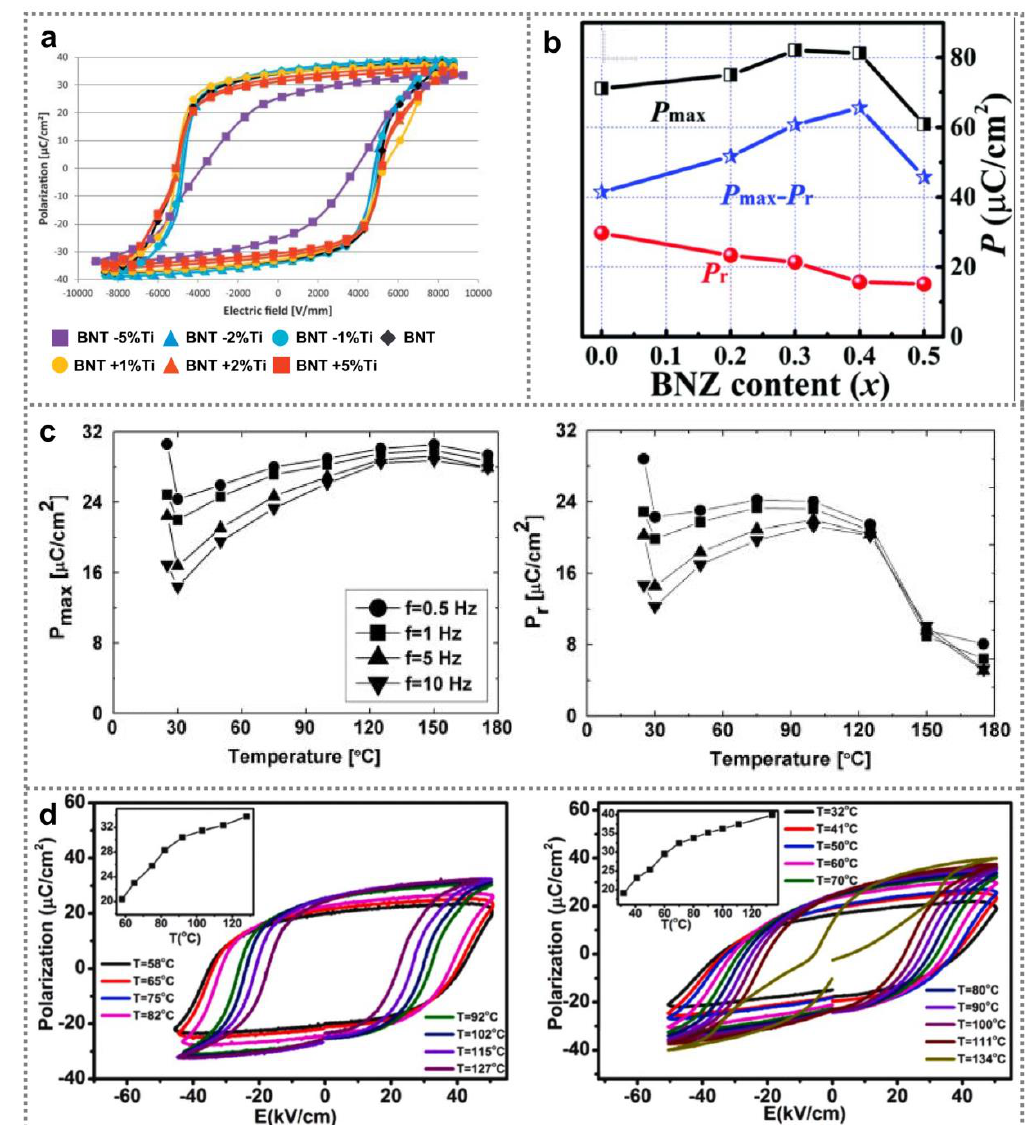
Figure 2. Ferroelectricity of BNT ferroelectric nanomaterials. ( a ) P - E hysteresis loop from BNT ceramic samples containing various amount of Ti (Reproduced with permission from [50], Elsevier, 2014). ( b ) P max , P r and P max – P r of BNT-xBNZ film under 2200 kV cm –1 electric field (Reproduced with permission from [52], RSC advances, 2018). ( c ) P r of 0.95(0.94BNT- 0.06BT)-0.05CaTiO 3 ceramic samples as a function of temperature (Reproduced with copyright permission from [55], AIP Publishing, 2013) ( d ) BNT-xBT ceramic disks ’ P - E loops at different temperature, and corresponding P r of the samples as a function of temperature (Reproduced with permission from [56], Elsevier, 2019).